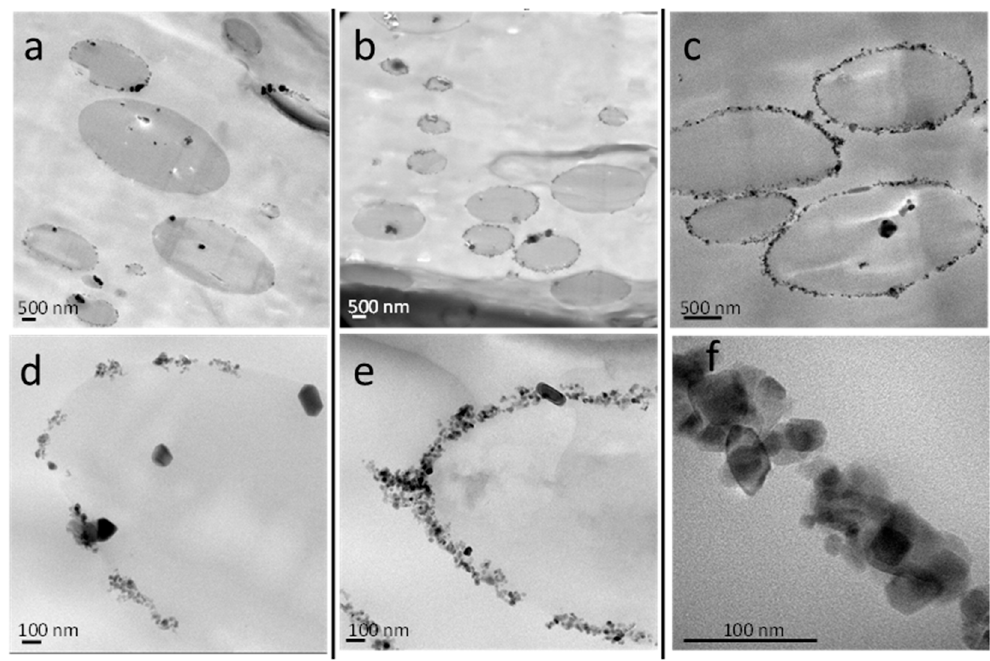
Figure 7. TEM images of PBNANO-hphoM with: ( a , d ) 3% ( b , e ) 7%, and ( c , f ) 12% TiO 2 .